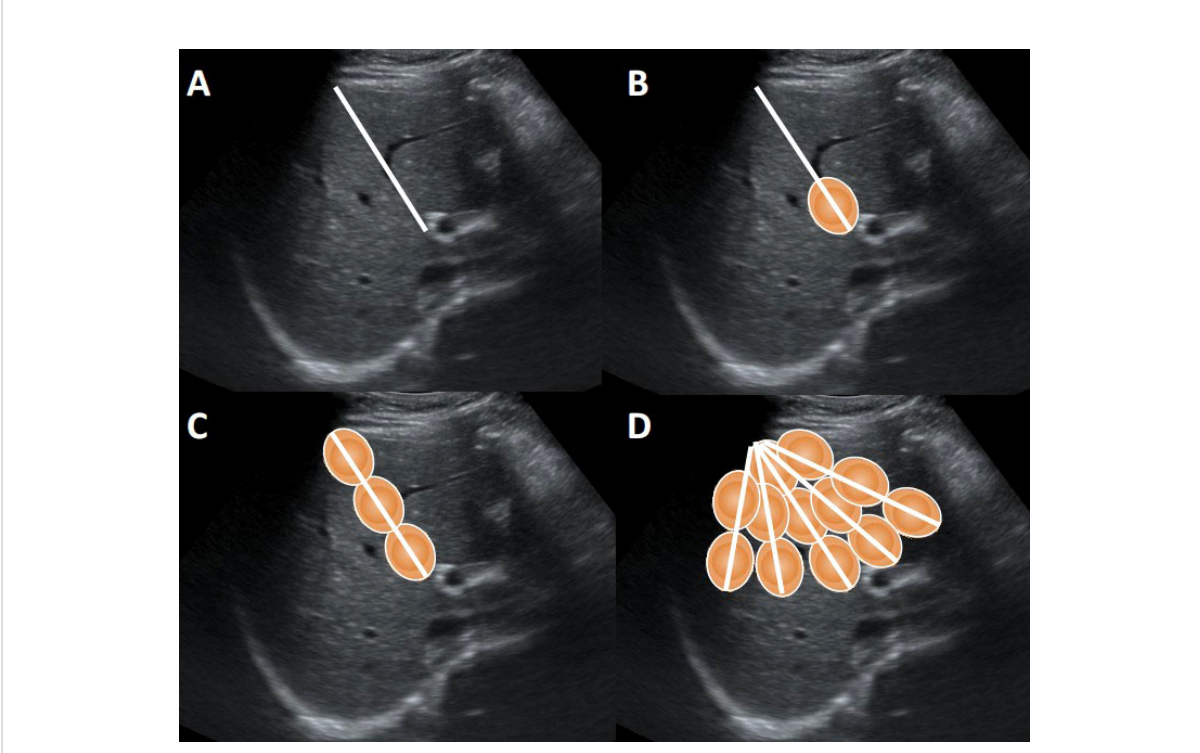
FIGURE 1 The multi-point multi-axis fan-shape ablation method. (A) Design needle path for ablation. (B) The one-point ablation. (C) The one-axis ablation. (D) The fan-shaped planar